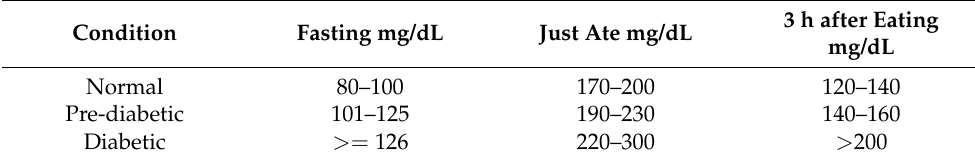
Table 1. Typical blood glucose levels of adult